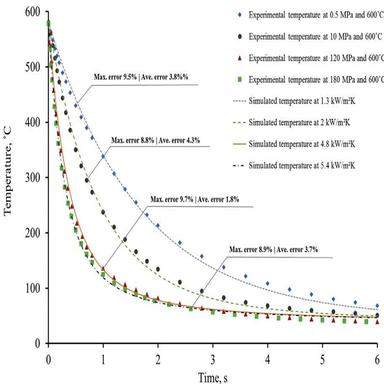
The temperature evolutions of the Ti-6Al-4V at 600 °C under lubricated conditions quenched by the H13 tools.